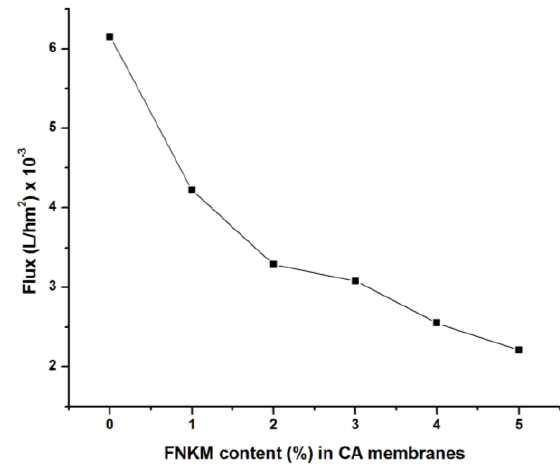
Figure 8. Correlation between FNKM loading contents and flux.